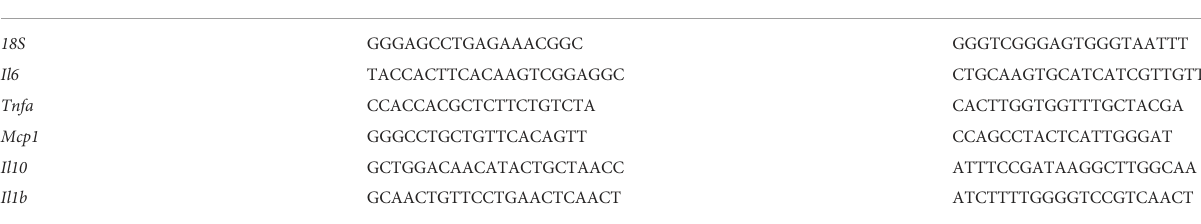
TABLE 2 Sequences of DNA primers used in RT-qPCR